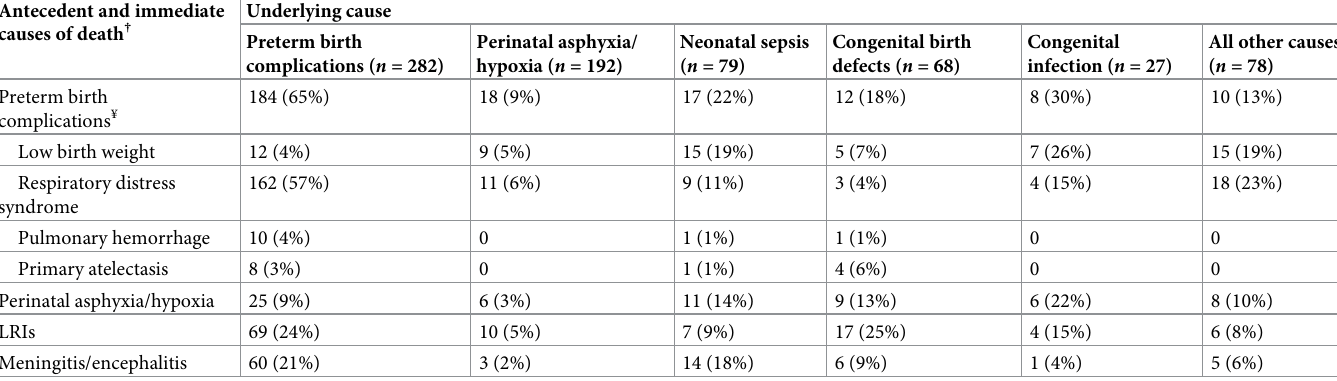
Table 6. Most common additional conditions (antecedent and immediate CoD) in the causal chain for the 5 leading underlying causes of neonatal deaths in CHAMPS. � Antecedent and immediate causes of death